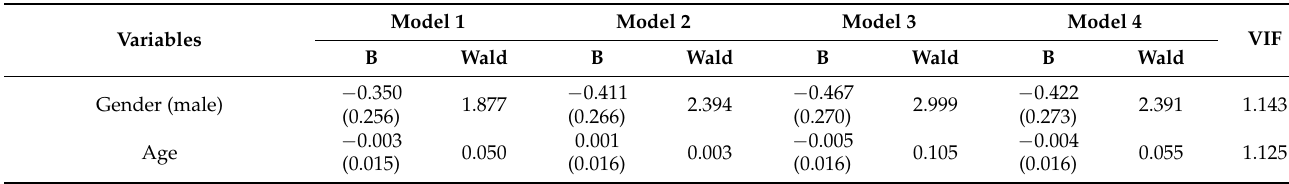
Table 3. Multiple Ordered Regression